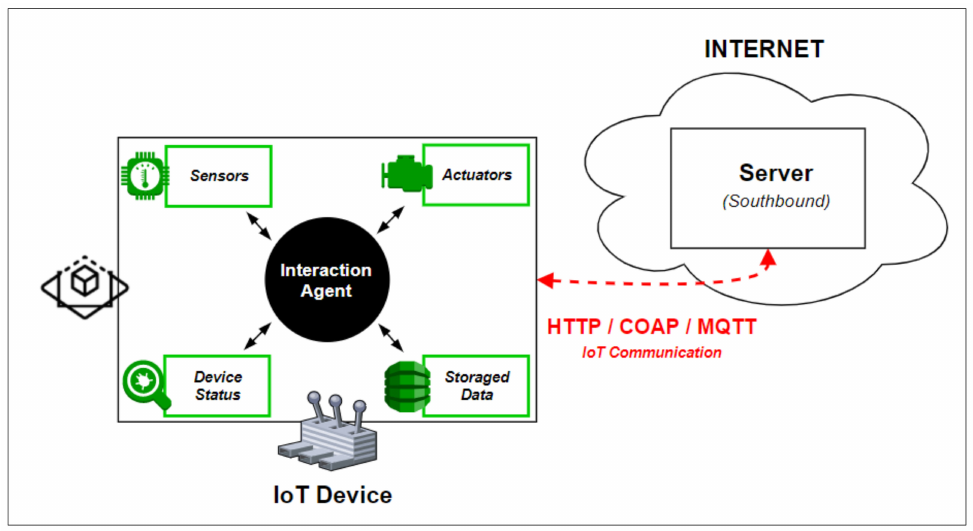
Figure 7. Interaction module architecture.